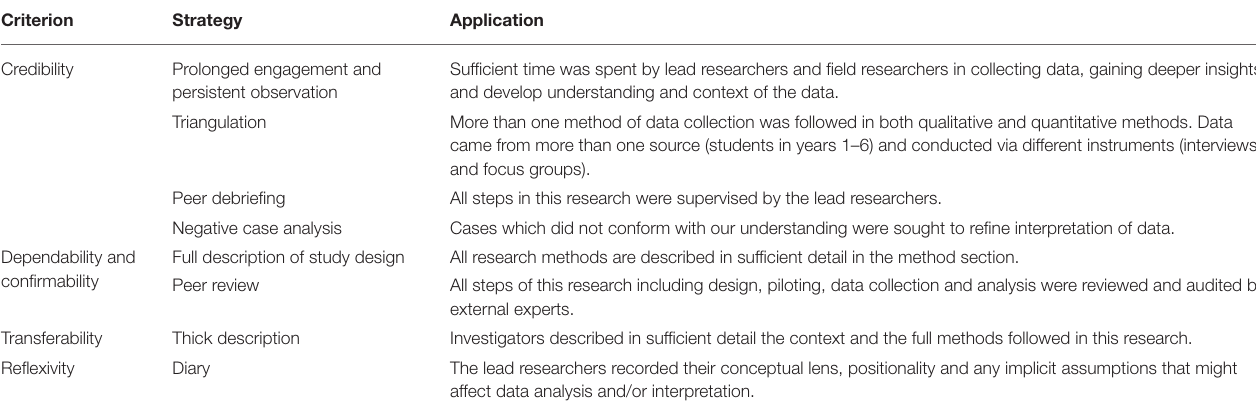
TABLE 2 | Qualitative study quality assurance measures. Criterion Strategy